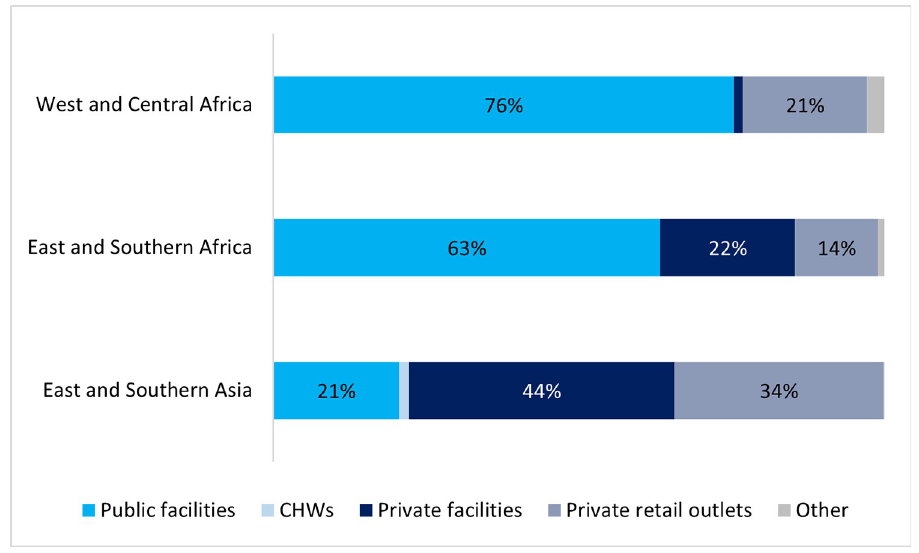
Fig 5. Sources of care for neonates by region, among neonates sick with fever whose caregivers sought treatment or advice outside the home.